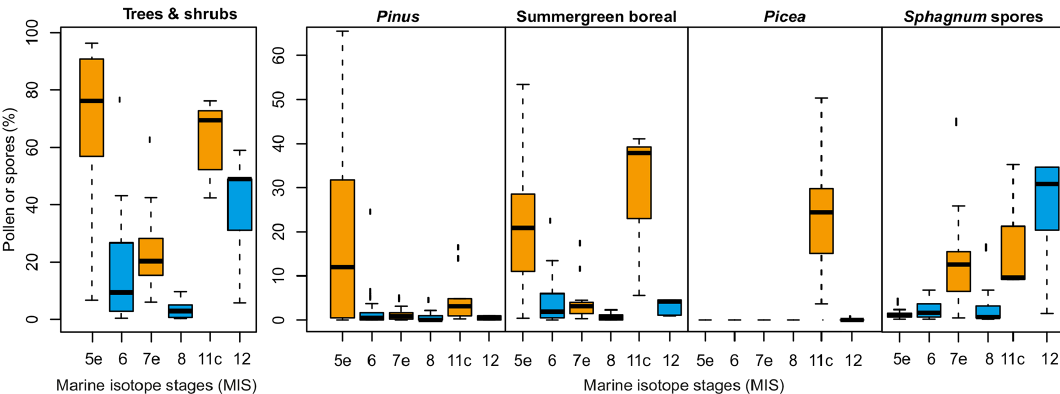
Figure 5. Boxplots of vegetation composition for the marine isotope stages of interest based on pollen samples. MIS 6–5e, 8–7e: this study; MIS 12–11c: after Melles et al. (2012); SGB: sum of Larix , Populus and Alnus pollen; Pinus : P. s/g. Haploxylon -type pollen; trees and shrubs: sum of Betula SGB, Salix , Pinus and Picea ; MIS 12: 430–424kyr ( n = 4); MIS 11c: 423–406kyr ( n = 10); MIS 8: 272–243 kyr ( n = 11); MIS 7e: 242–193kyr ( n = 21); MIS 6: 190– 134kyr ( n = 37); and MIS 5e: 132–110kyr ( n = 25), with blue (orange) boxes marking late glacial (interglacial)